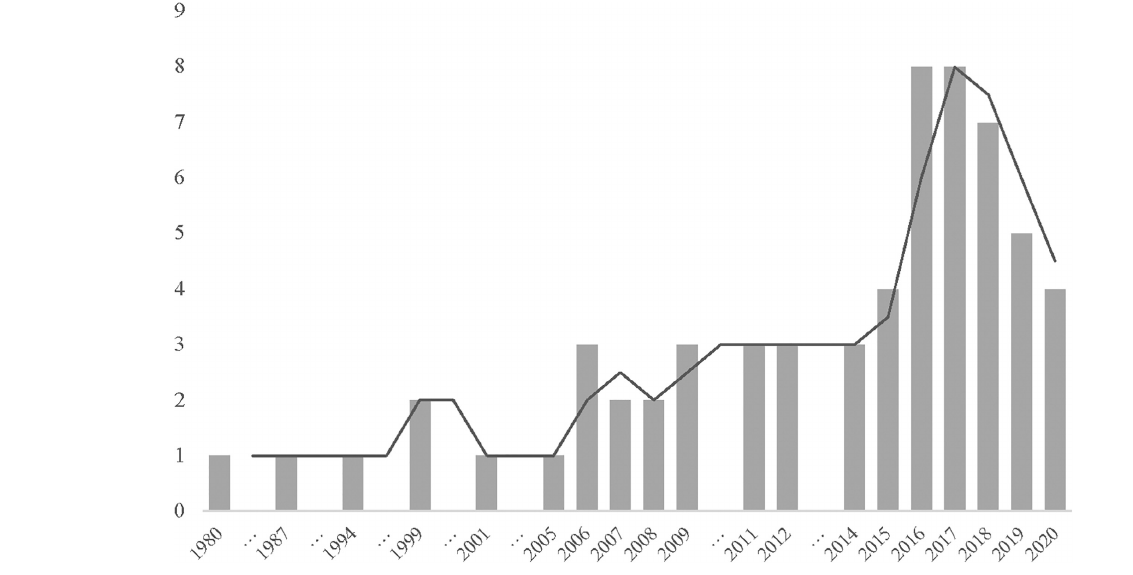
FIGURE 2 | The number of peer-reviewed publications related to humor and workplace leadership. Trend line represents moving average. 2019 figure does not represent the full calendar